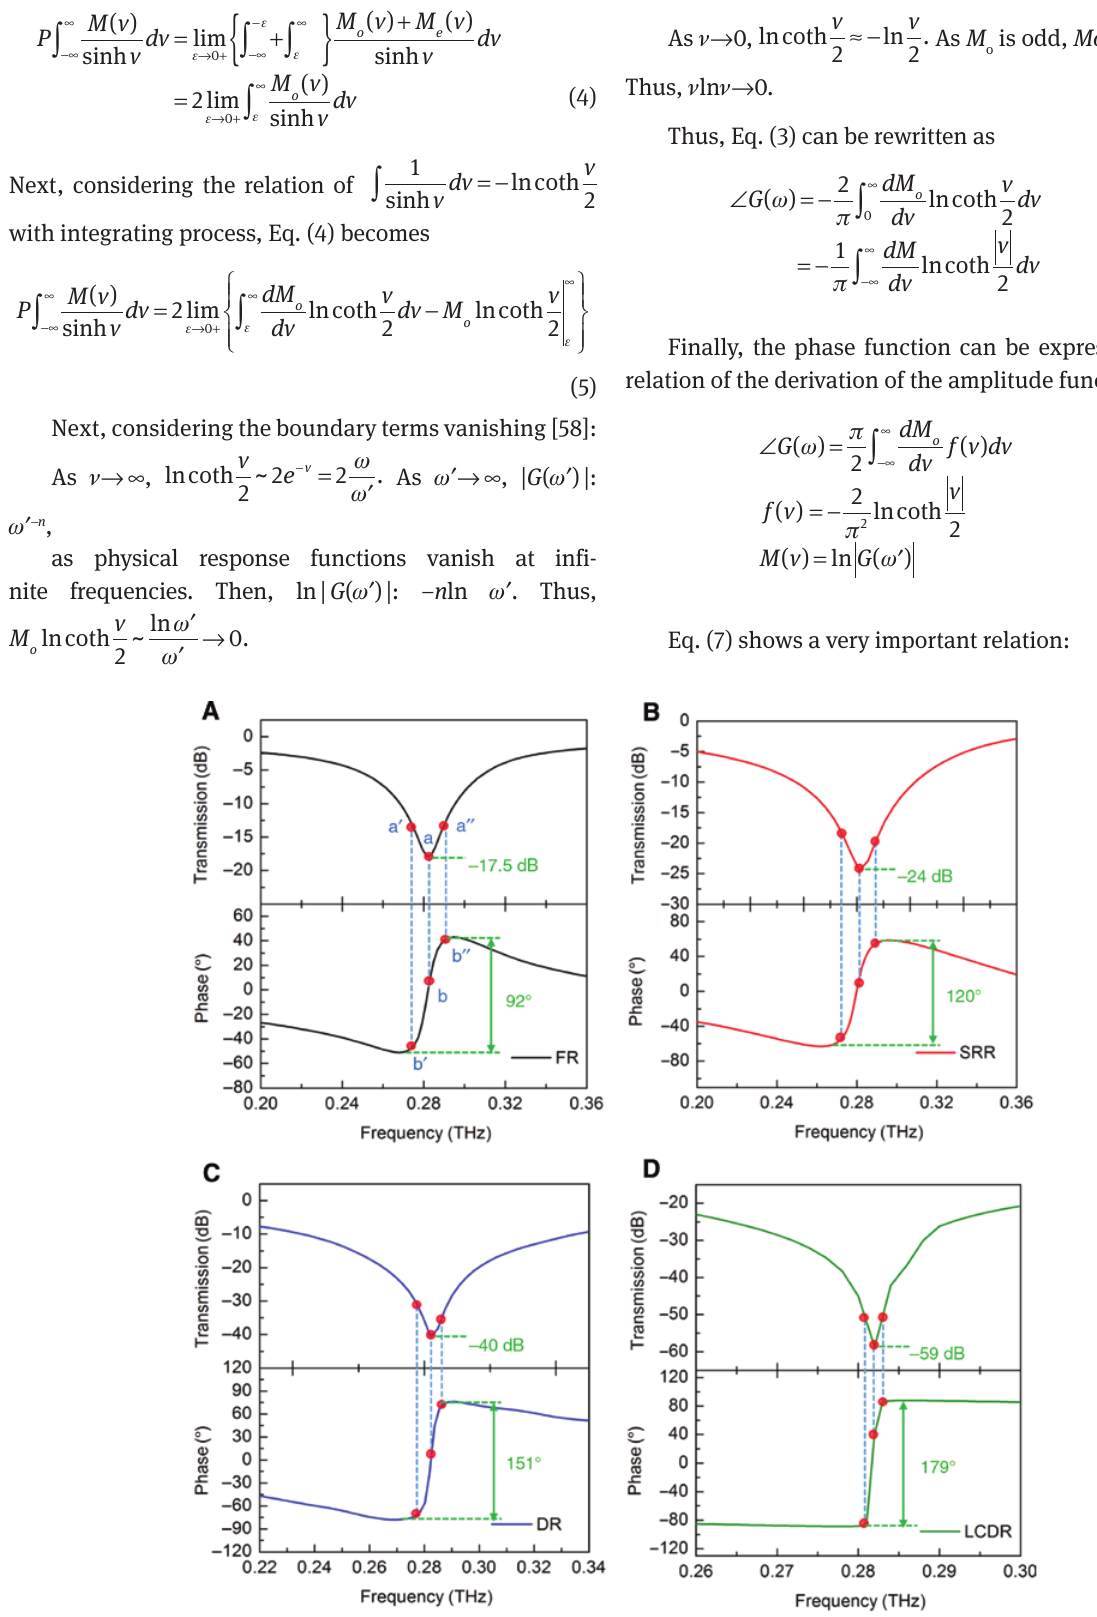
Appendix-Figure 8: Transmission and phase spectra for different structures: (A) FR, (B) SRR, (C) DR, and (D)